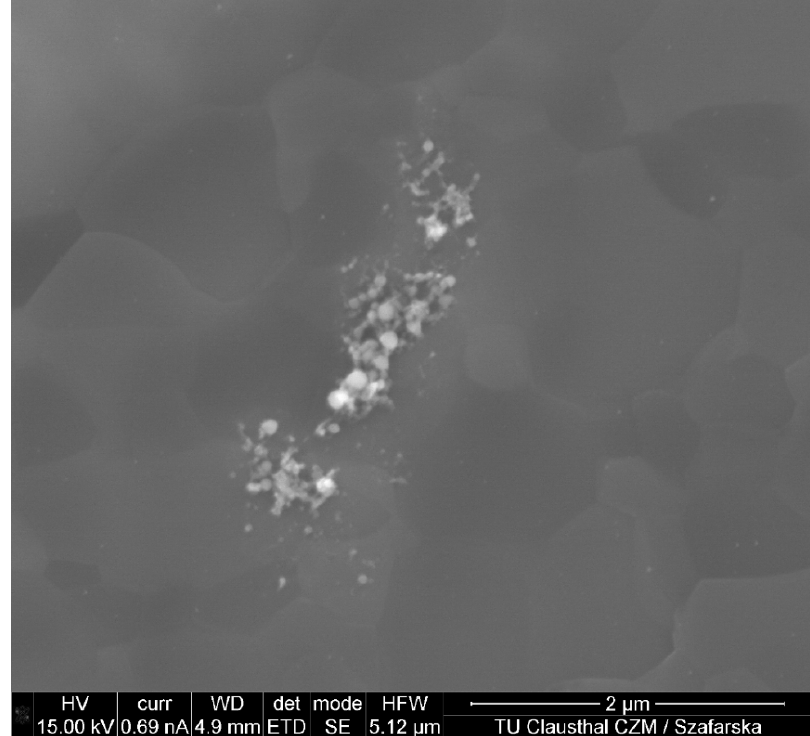
Figure 8. SEM image of SiO 2 agglomerates on a copper particle atomised in silane-doped nitrogen.